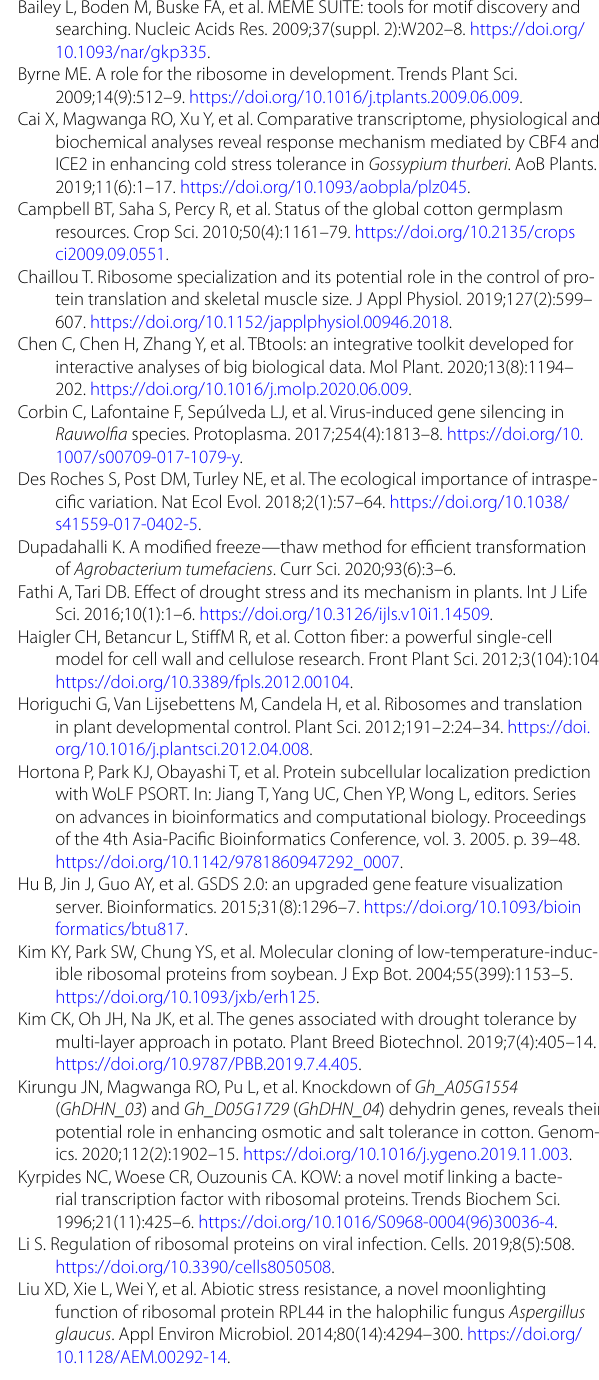
Additional file 1: Table S1. Physiochemical properties of the proteins encoded by the RPL14B genes. Additional file 2: Table S2. List of primers for the RT-qPCR profiling of the cotton RPL14B gene under drought and salt stress conditions. Acknowledgements Not